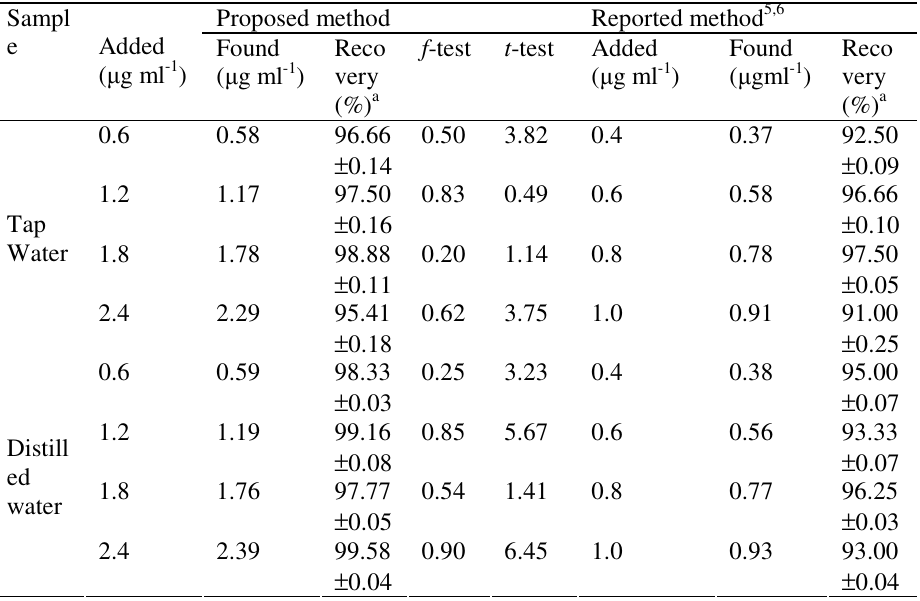
Table 2 Recovery of Carbofuran from fortified water samples 4.4-azo-bis-3,3 ′ 5,5 ′ -tetra bromo aniline Proposed method Reported method 5,6